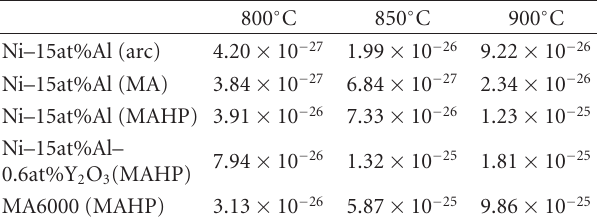
Table 3: The growth rate constant K (cid:2) (m 3 /s) of γ (cid:2) precipitates at 800 ◦ C, 850 ◦ C, and 900 ◦